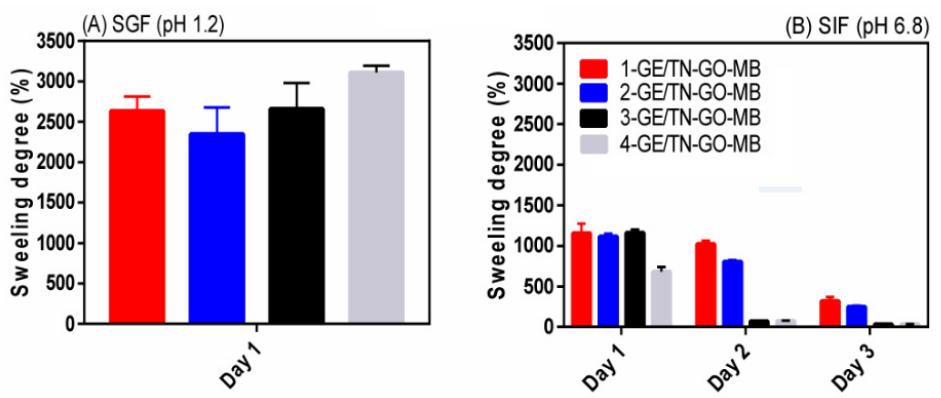
Figure 8. Results of the swelling degree obtained for the GE/TN-GO-MB hydrogels with different